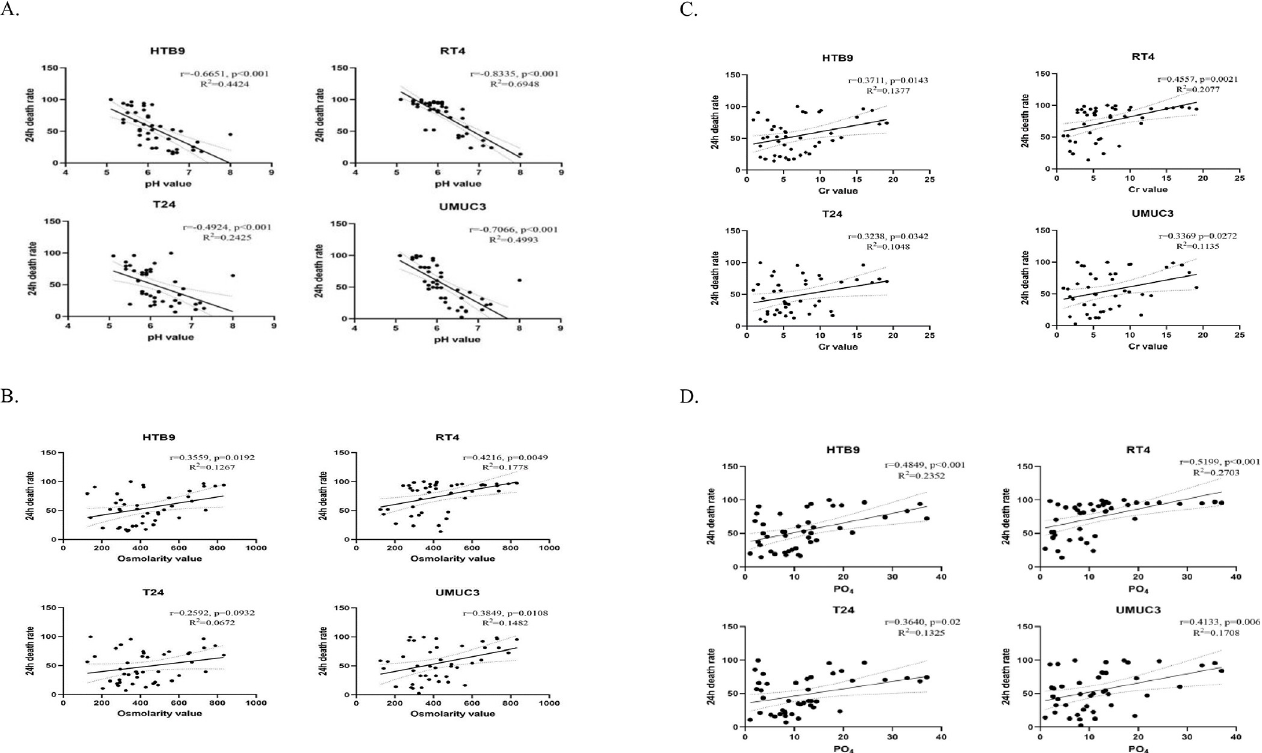
Fig 3. Correlation between the cancer cells’ 24h death rate and different chemical parameters of urine. (A) pH value strongly correlated with 4 cancer cell lines’ death. Urine’s (B) osmolarity, (C) Creatinine Cr and (D) phosphate PO 4 value had a moderate and positive relationship with bladder cancer cells’ death, thus increasing human urine’s